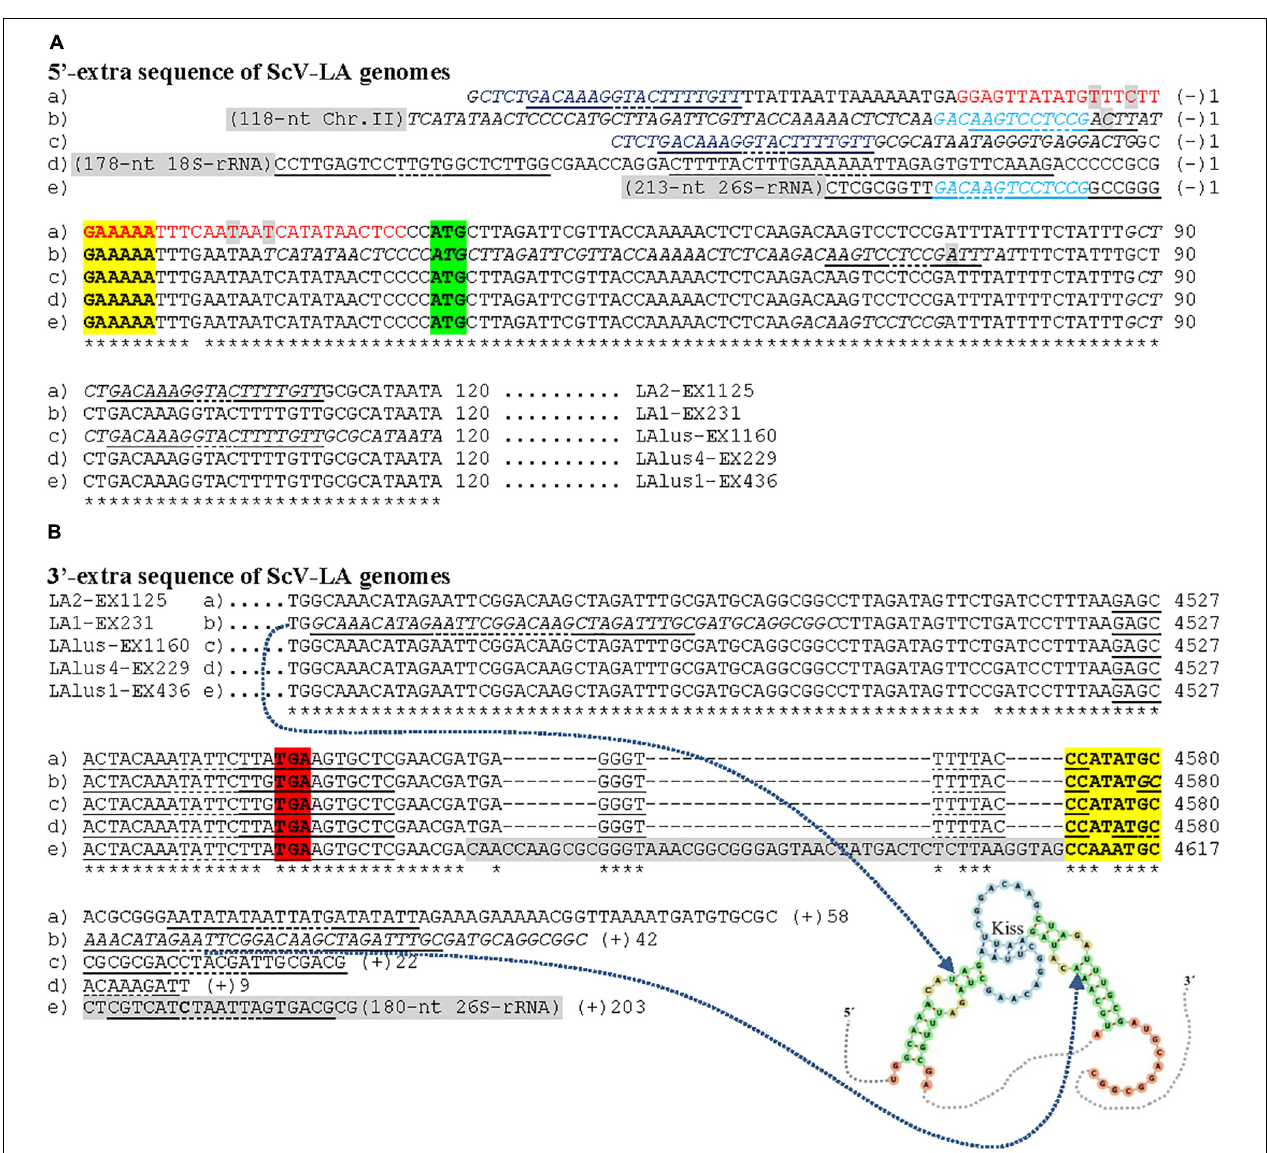
FIGURE 5 | Nucleotide sequence (cDNA) alignment of 5 (cid:48) - (A) and 3 (cid:48) -extra (B) sequences, and proximal canonical sequences of ScV-LA genomes from S. cerevisiae strains isolated from Ribera del Guadiana: (a) LA2-EX1125; (b) LA1-EX231; (c) LAlusA-EX1160; (d) LAlus4-NGS; (e) LAlus1-EX436. Asterisks (*) indicate identical nucleotides. The 5 (cid:48) -GAAAAA and CCA(T/A)TGC-3 (cid:48) ends of canonical sequences are in boldface and yellow highlighted. The protein synthesis initiation and stop codons of Gag-Pol are shaded in green and red, respectively. Sequence stretches that are homologous in two different virus genomes are light-blue or dark-blue shaded. The 5 (cid:48) -extra sequences that are homologous to rRNA or chromosome II sequences of S. cerevisiae are light- gray shaded. Nucleotides of palindromic sequences are shown in red. Duplicated sequences in each virus are in italics. Stem loops are underlined, and unpaired nucleotides of each loop are dot underlined. The possible kissing stem-loop secondary RNA structure in ScV-LA1-EX231 is shown at the bottom of the